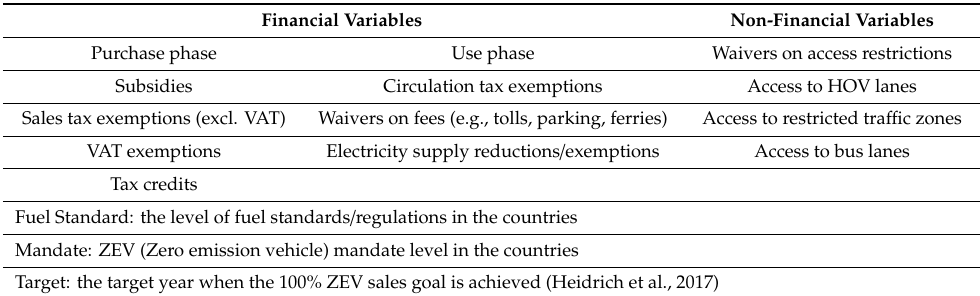
Table 3. Financial and non-financial